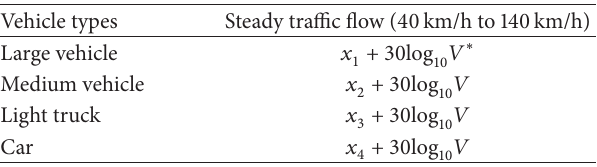
Table 3: A-weighted sound power levels ( 𝐿 different surface types.